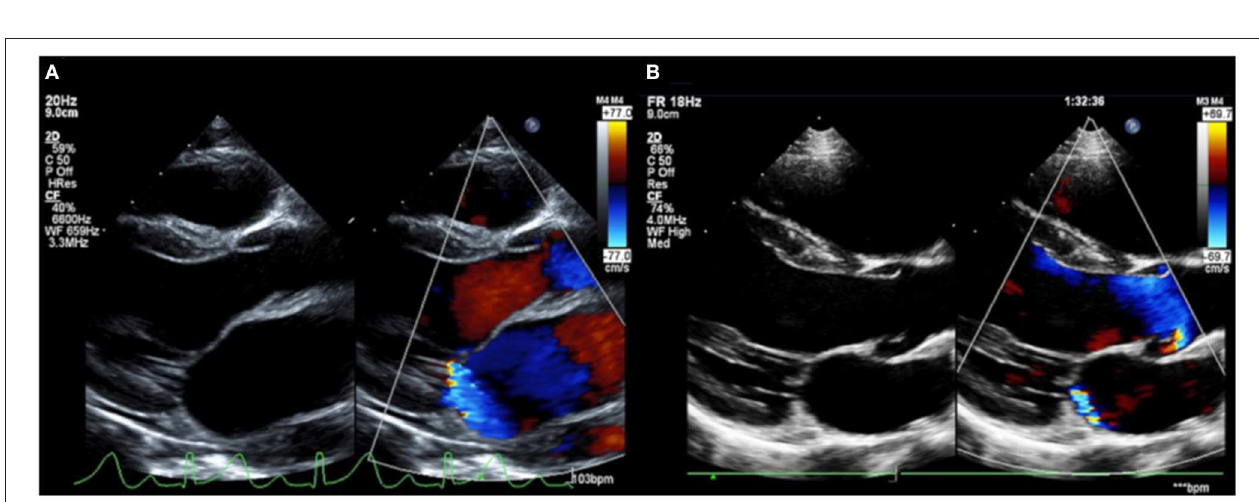
FIGURE 3 | Severe mitral regurgitation on the diagnosis of acute rheumatic fever (A) . Mitral regurgitation showed dramatic improvement at the 1-year follow-up (B)